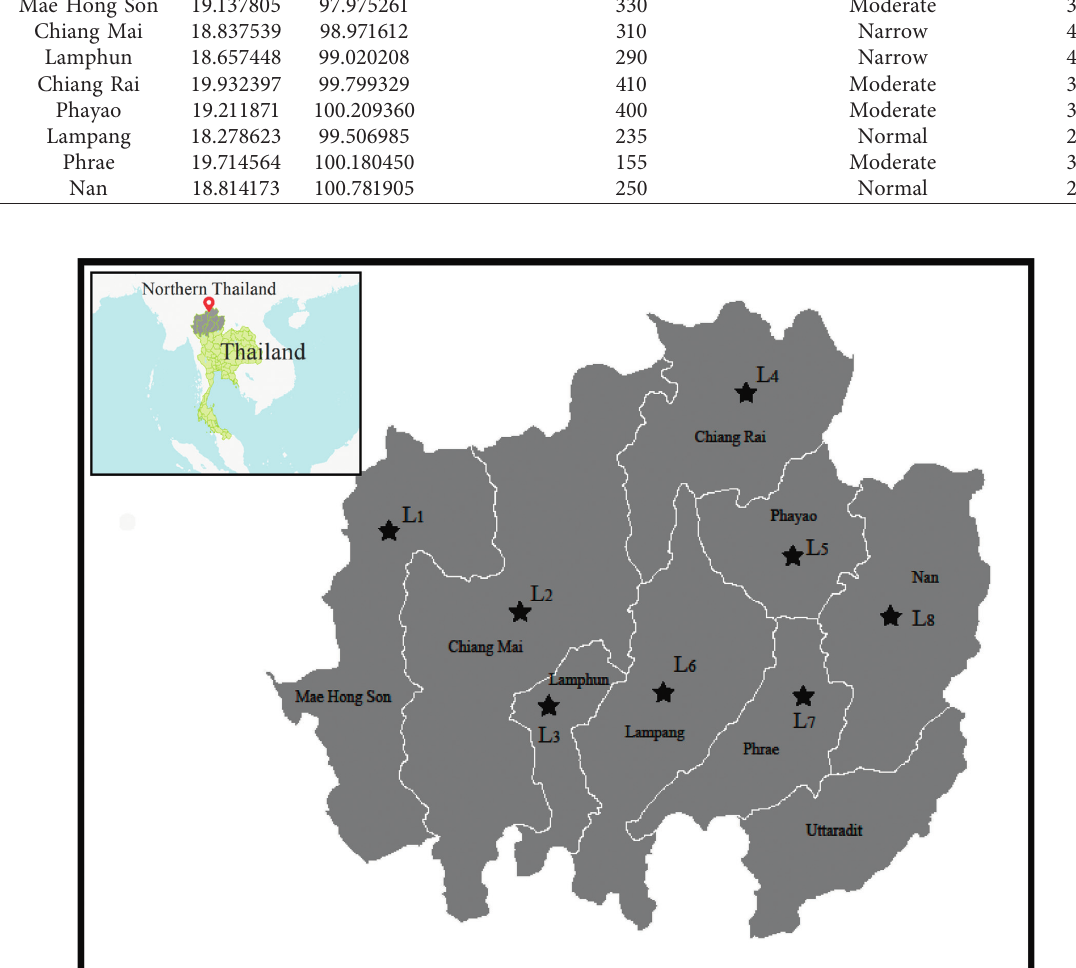
Figure 1: The study area: eight selected provinces in the northern region of Thailand. The figure is obtained from Samphutthanon et al. [29]. 50.00100.00150.00200.00250.00300.00 0.00